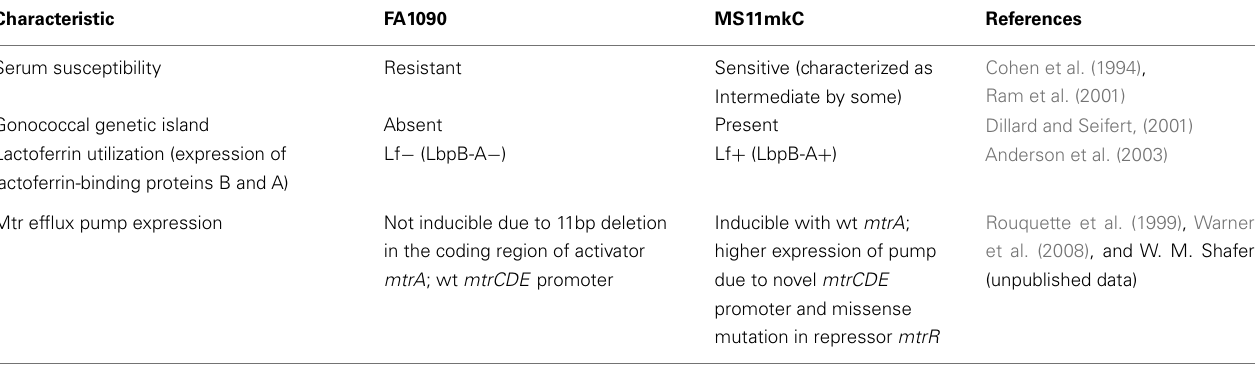
Table 1 | Recognized differences between N. gonorrhoeae strains FA1090 and